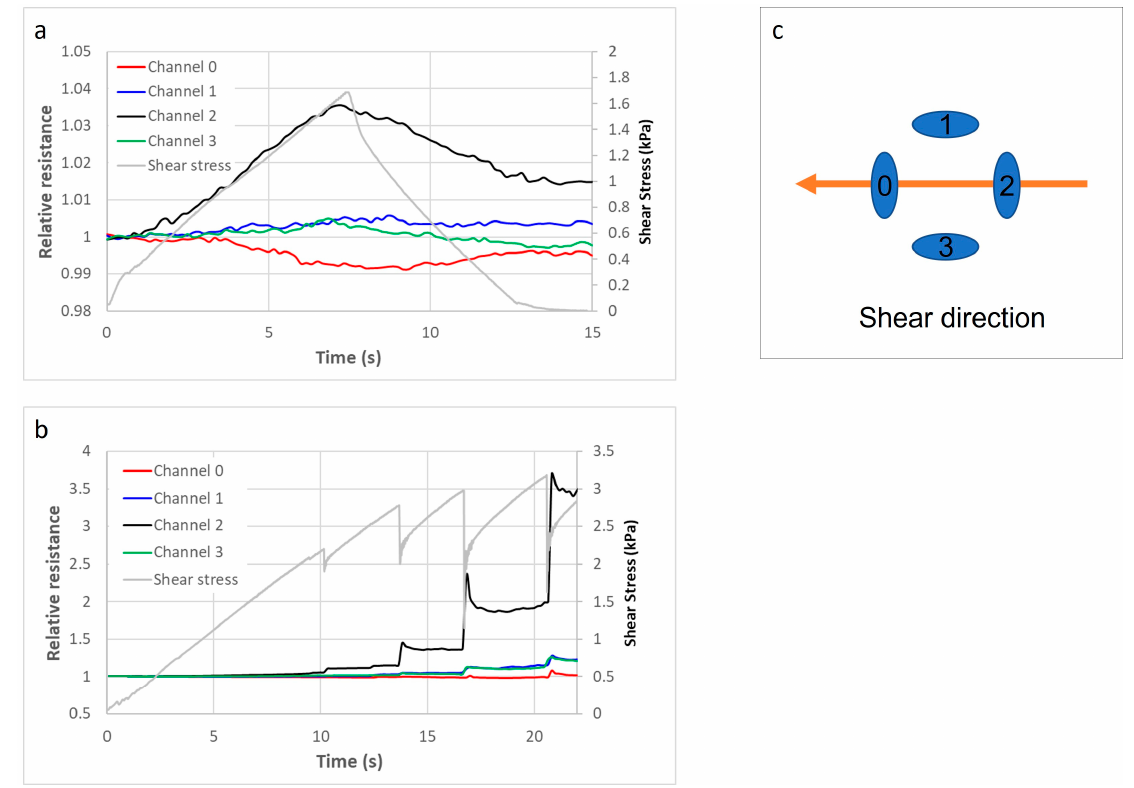
Figure 28. Principle drawing showing a loss of friction/slippage event.